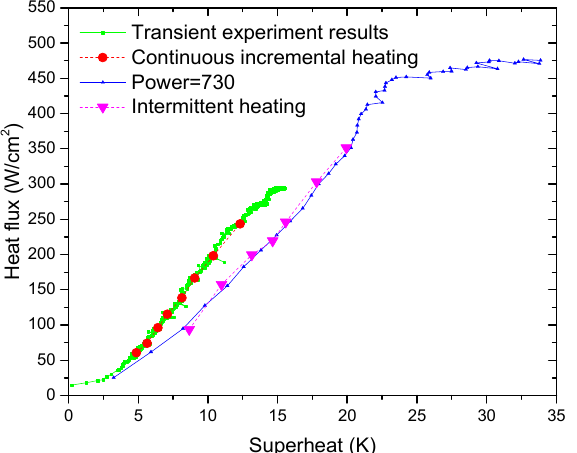
Figure 10. Effect of different heating conditions on the boiling heat transfer performance.